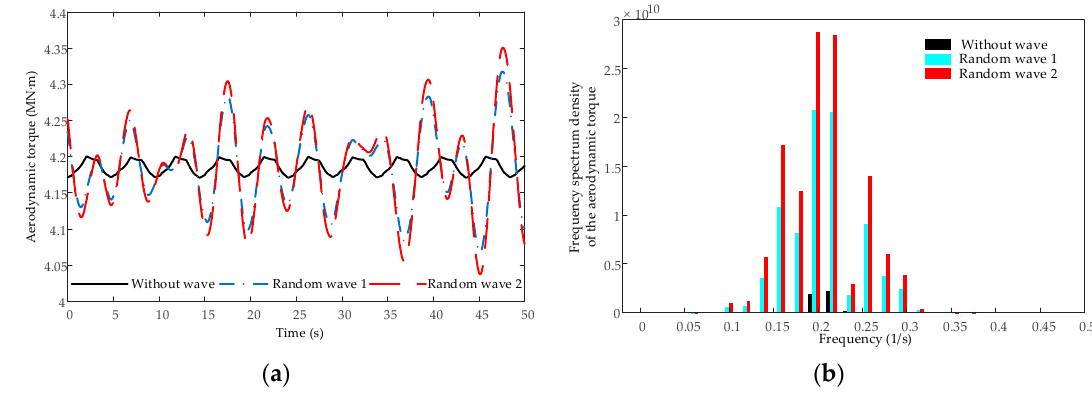
Figure 9. Time domain and frequency domain results of the aerodynamic torque without and with random wave: ( a ) The aerodynamic torque; ( b ) Frequency spectrum density of the aerodynamic torque.